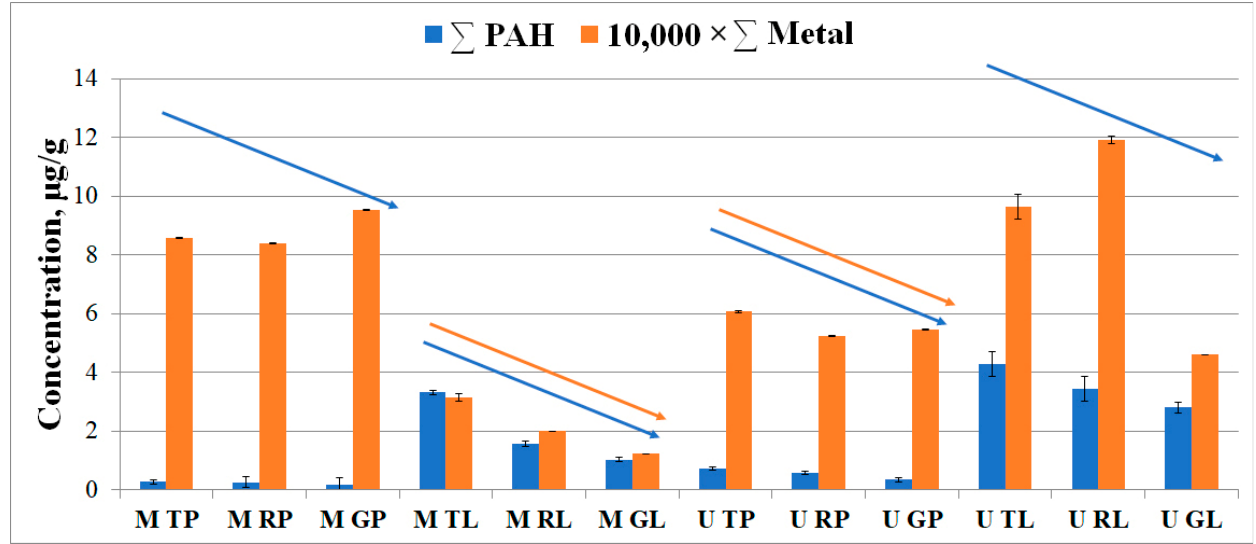
Figure 3. Total content of the PAHs (blue) and metals (orange) in biotopes of functional zones of Murmansk and Moscow. The first letter in the abbreviation refers to the city: M–Moscow, U–Murmansk; the second letter refers to the functional zone: T–traffic, R–residential, G–recreational; and the last letter refers to the biotope: L–leaf, P–paved surface. The data for metals were scaled down by a factor of 10,000 for visualization in the picture and compared to the dimensionality of the data for PAHs.